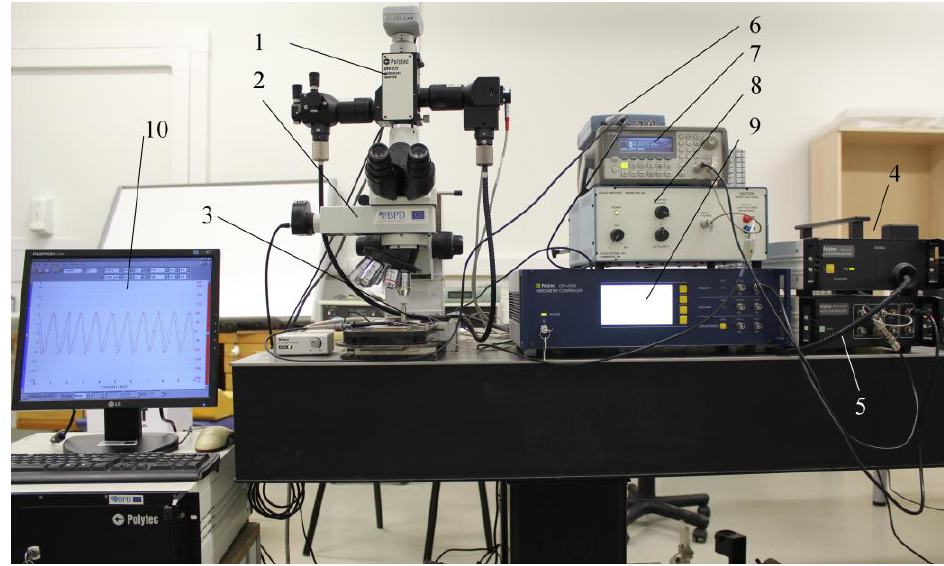
Figure 4. Photo of experiment setup: 1—Polytec OFV 072 Microscope adapter with Polytec OFV 073 Microscope scanner unit and Polytec OFV 071 Microscope manual positioner; 2—Nikon microscope Eclipse LV100 with digital video camera Pixelink PL-A662; 3—piezoelectric actuator PSt 150/4/20VS9